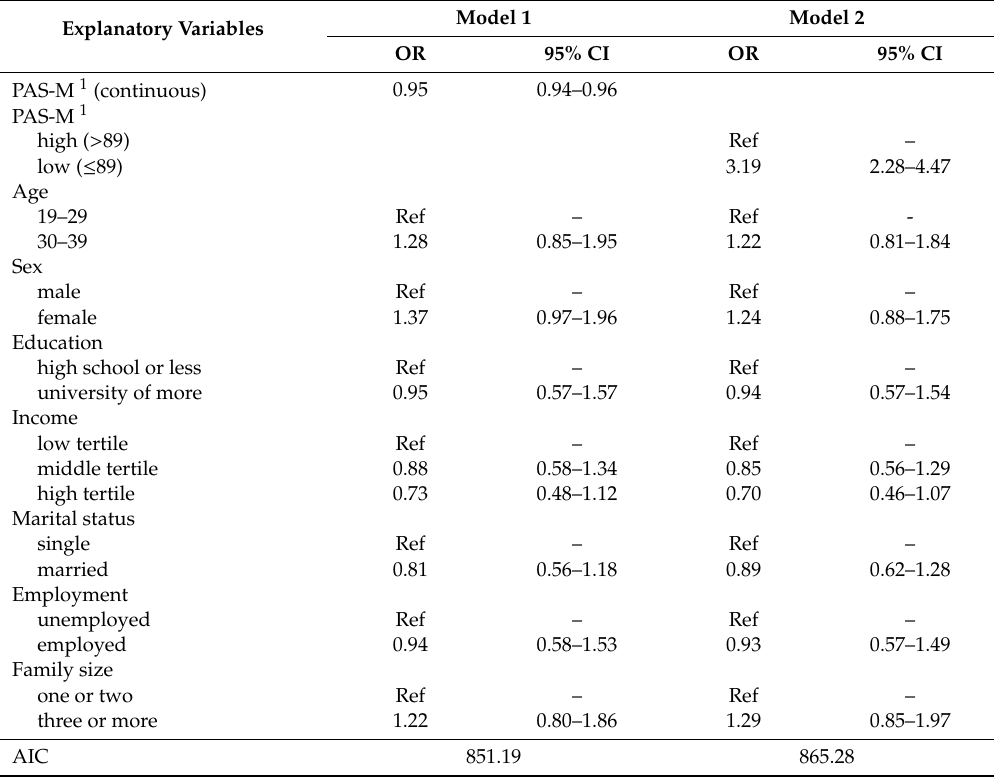
Table 4. Association of owners’ depression symptoms (categorical variables) with the modified Pet Attitude